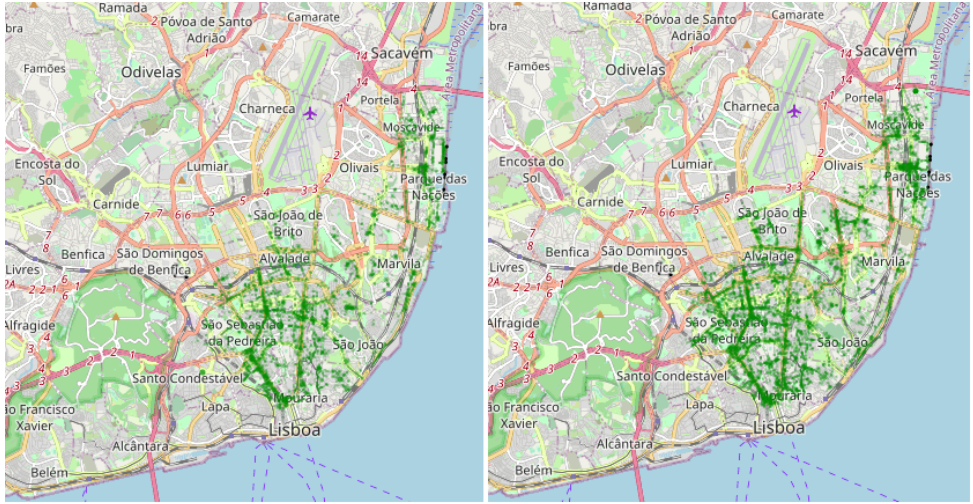
Figure 3. Geographical distribution of devices in Lisbon city center. 0 a.m. (on the left) and 12 p.m. (on the right) devices distribution, according to the telecommunication operator. Lighter means fewer devices, and darker means a higher concentration of devices. Background map source: Open- StreetMap